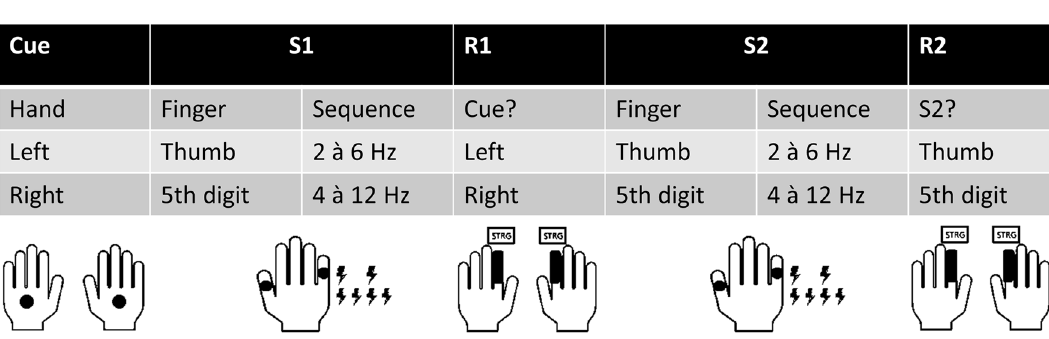
Figure 3. Schematic illustration of the experimental procedure. For clarity, one black dot represents a pair of electrodes. Electro-tactile stimuli were either applied to the thumb or little finger (5th digit) using a double (2 à 6 Hz) or quadruple (4 à 12 Hz) pulse. Details concerning stimulus and response timing can be found in “Materials and methods”